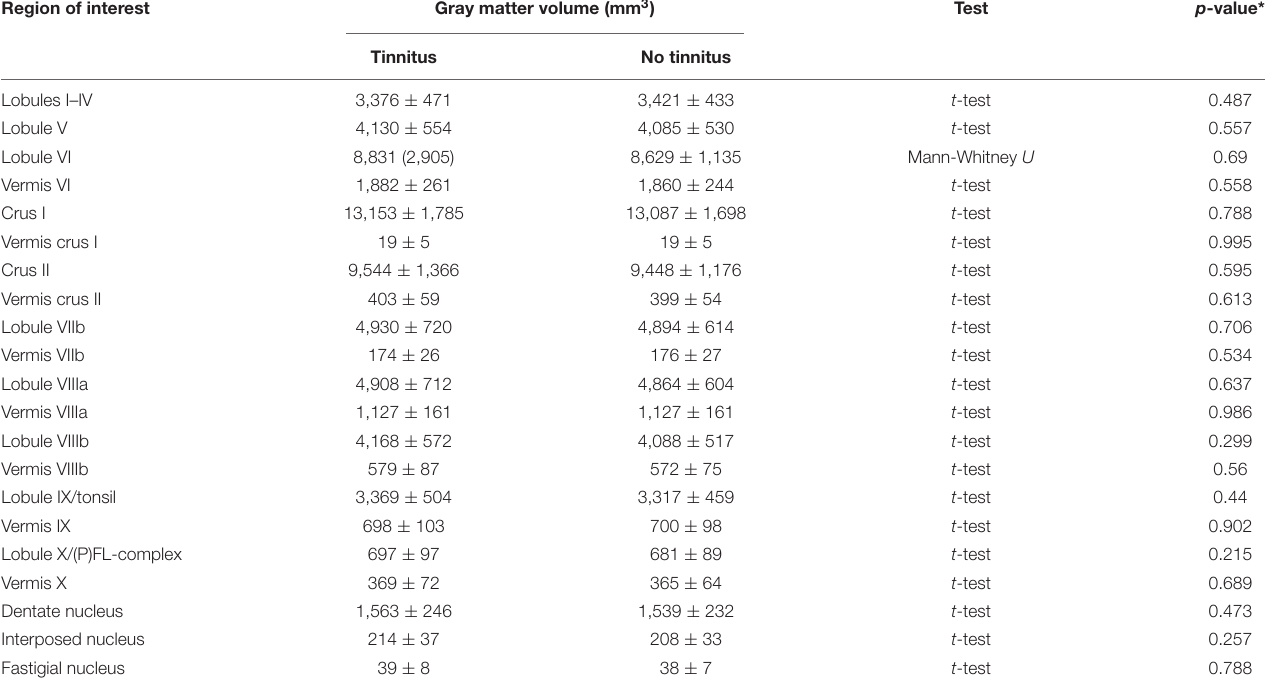
TABLE 3 | Differences in the gray matter volume (mm 3 ) of multiple regions of interest between tinnitus and non-tinnitus participants.